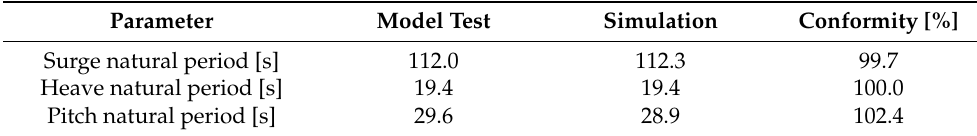
Figure 5. Free decaying test result. Table 7. Difference of FOWT motion natural period.